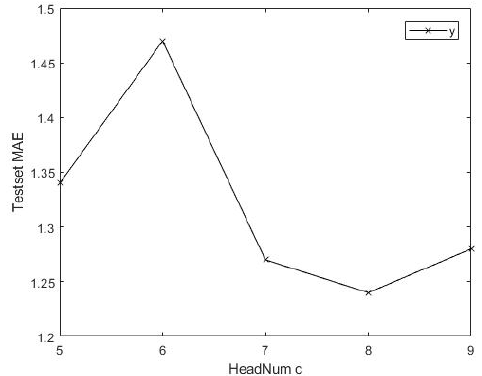
Figure 4. Effects of c .